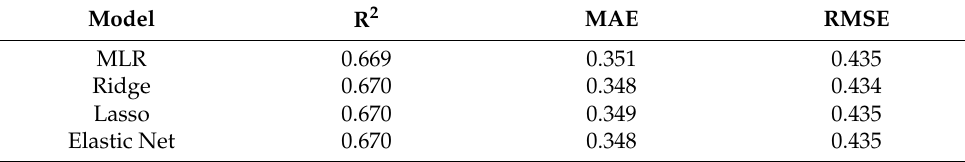
Table 5. Comparison of the regression